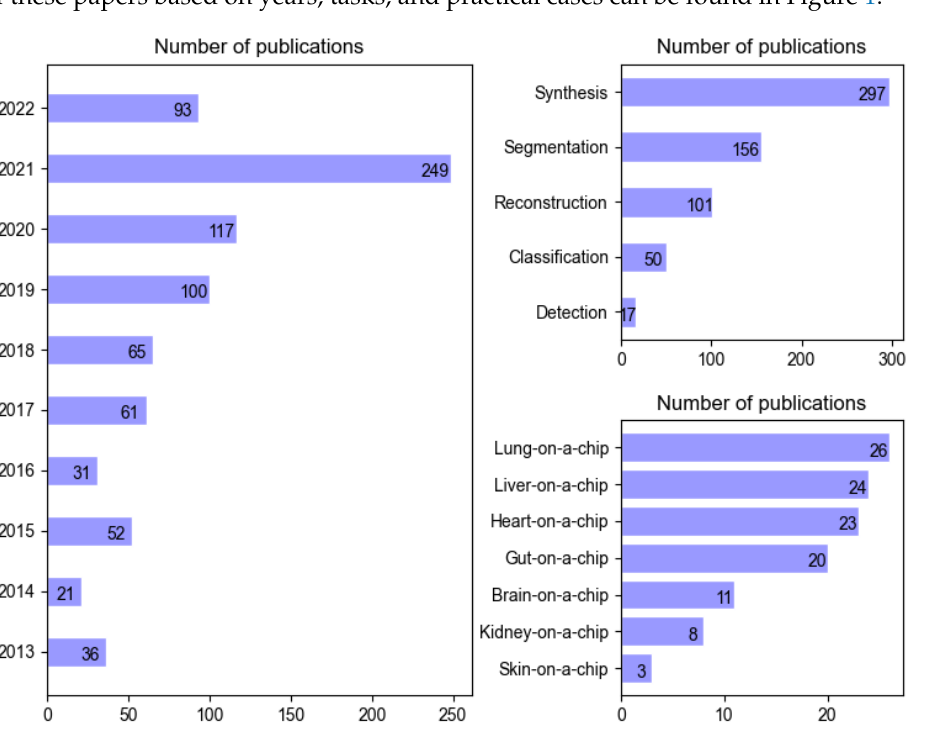
Figure 1. Breakdown of the publications included in this review according to the year of publication, task addressed in deep learning (Section 3), and application cases (Section 4). The number of publications for 2022 has been extrapolated from the publications published in or before